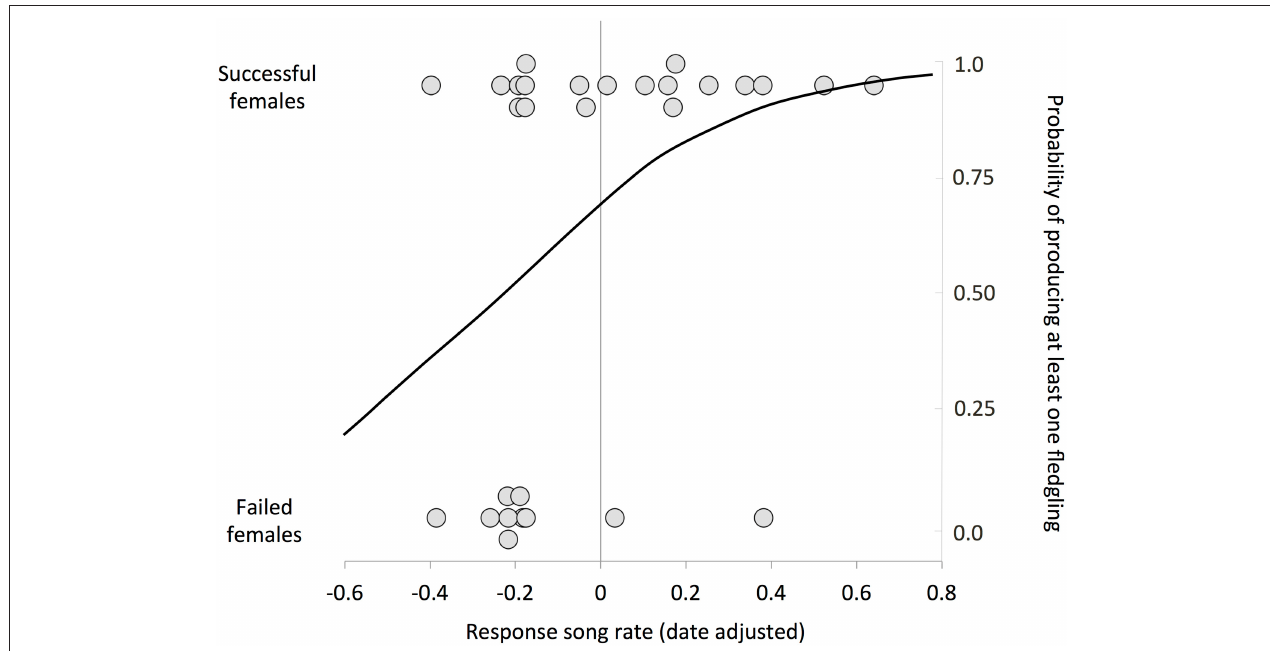
FIGURE 2 | Relationship between female response song rate and nest success. Response song rates were plotted according to whether the female was successful (produced at least one fledgling) or failed in all attempts; overlapping points are jittered for clarity. Line is a logistic regression estimating the probability that a female with a given response score would be successful.